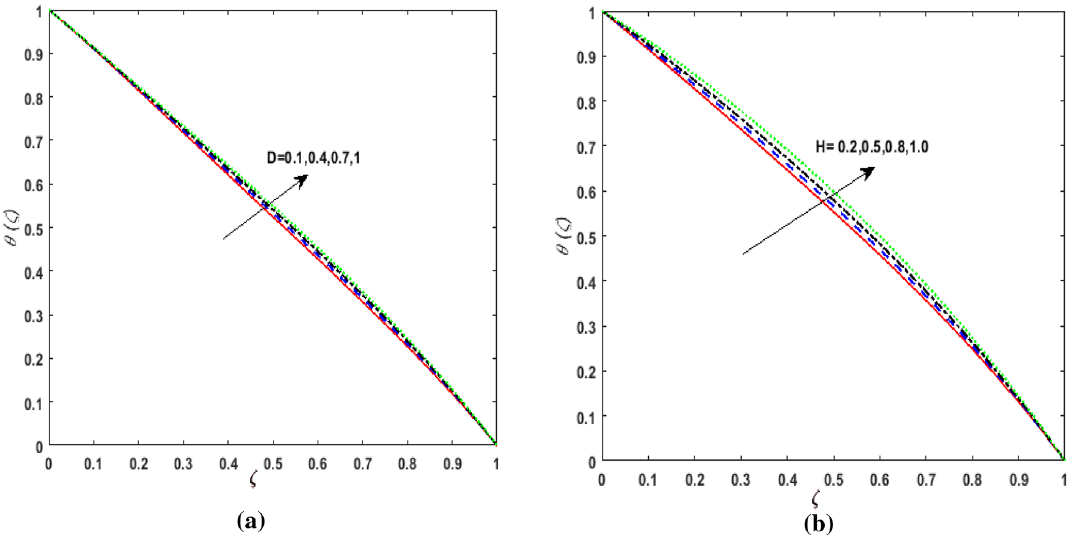
Figure 11. ( a ) Effect of temperature dependent source parameter D > 0 on temperature θ(ζ) . ( b ) Effect of space dependent source parameter H > 0 on temperature θ(ζ) .